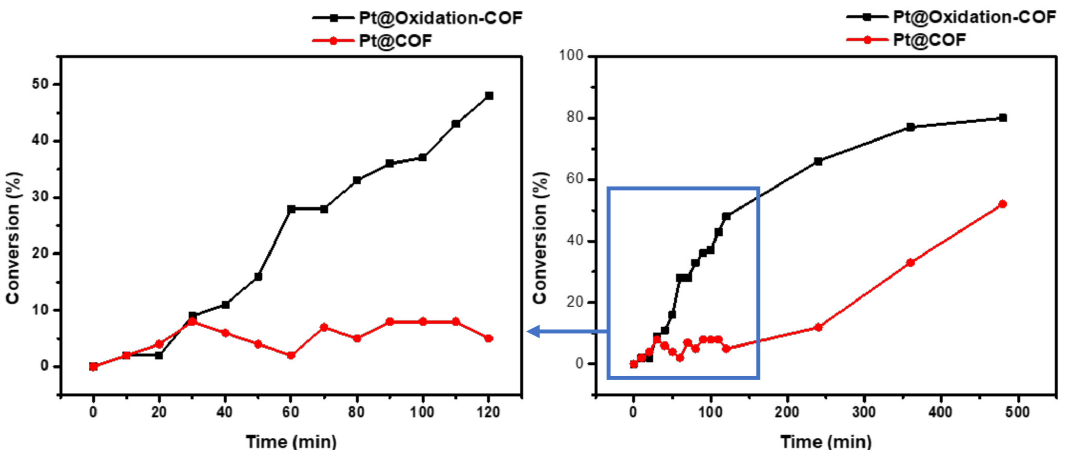
Figure 6. Catalytic activity investigations of Pt@BHU-2 and Pt@BHU-2-Oxidate in the addition reac- tion between dimethylphenylsilane and styrene. Reaction conditions: styrene (10.42 mg, 0.1 mmol), dimethylphenylsilane (27.25 mg, 0.2 mmol) catalyst (1 mg), toluene (1 mL), temperature (60 o C), time (8 h), and